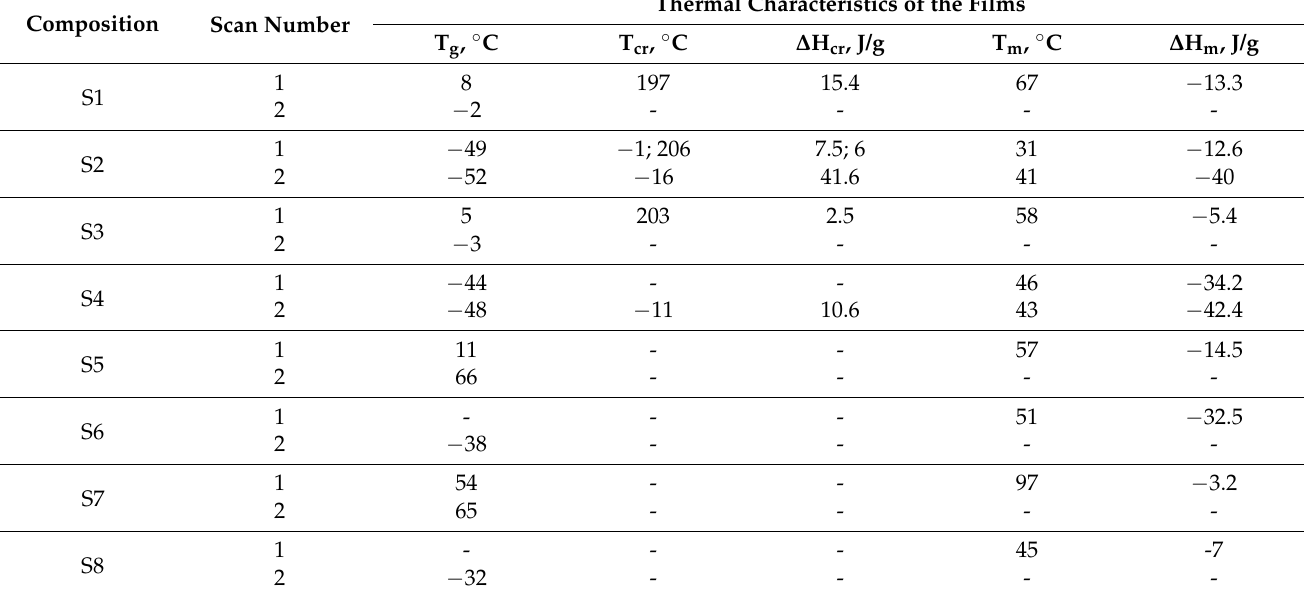
Table 2. Thermal properties of segmented PUU.